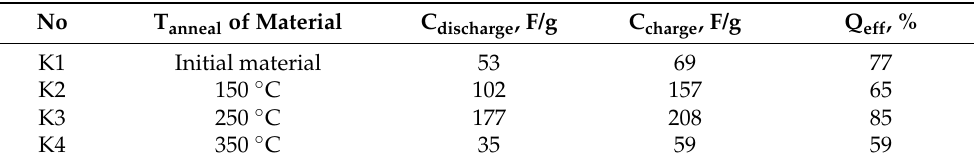
Table 2. Calculated specific values of charging and discharging capacities and Coulomb efficiency for materials synthesized at different annealing